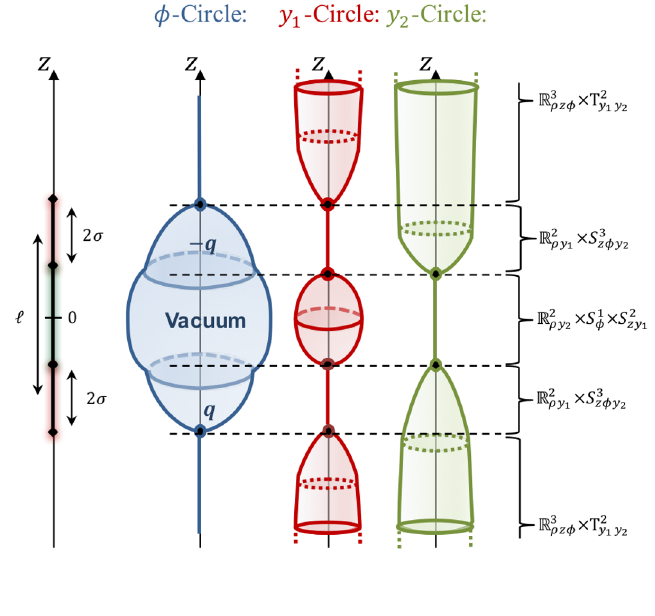
Figure 13 . Schematic description of the smooth neutral three-bubble configuration and the behavior of the φ , y and y circles on the z 1 2